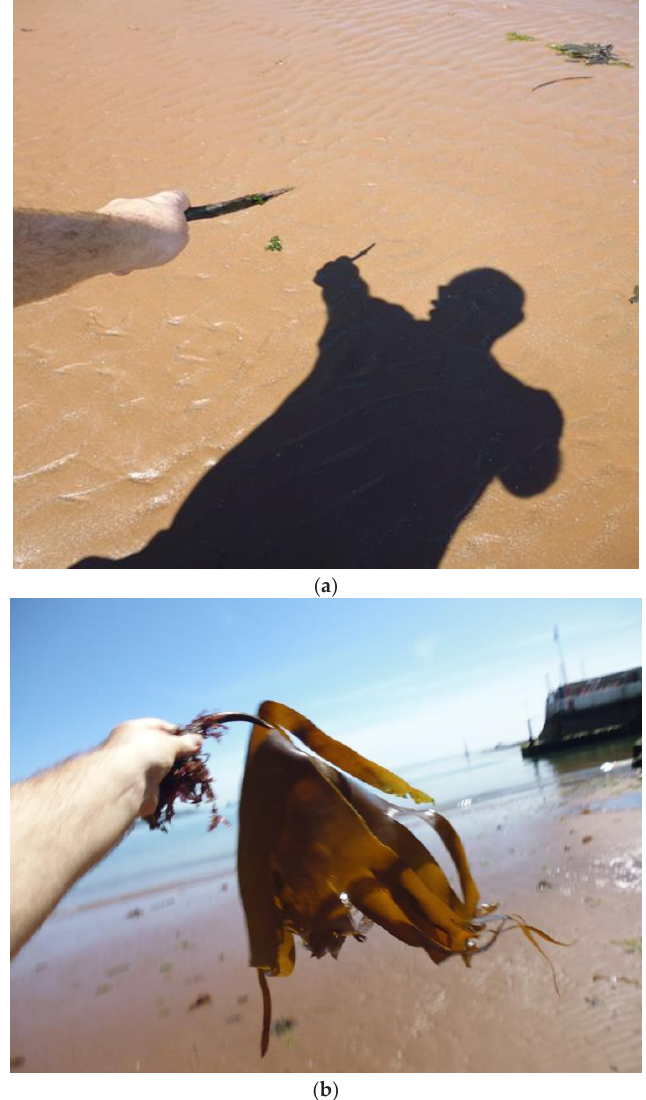
Figure 4. ( a ) Stick; ( b ) Seaweed.